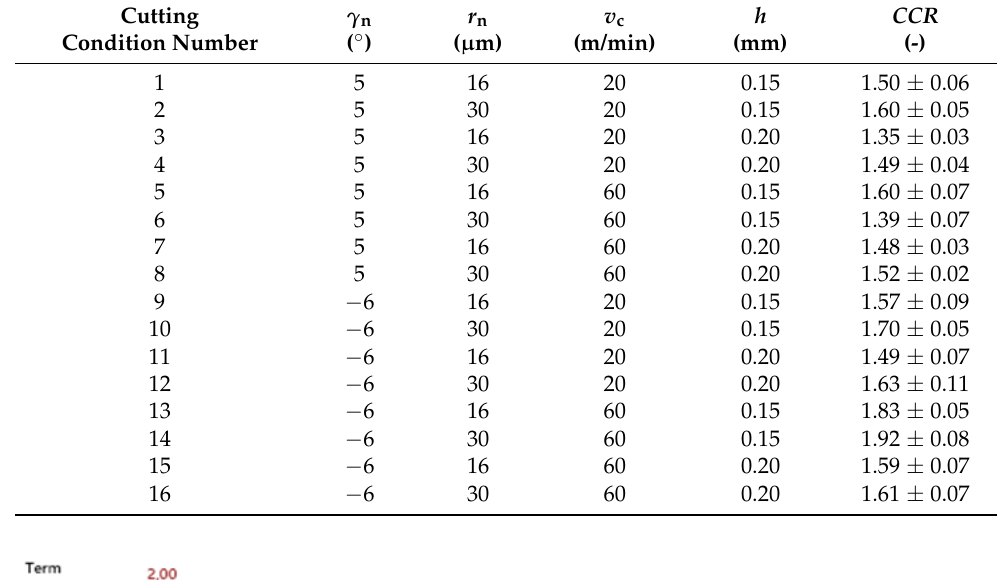
Table 6. Calculated CCR based of the measurements to the chip geometry.